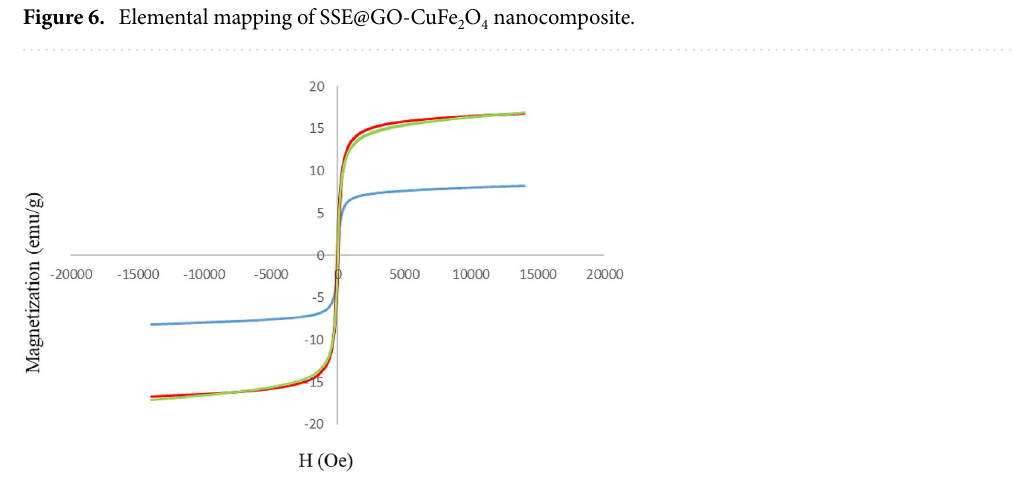
Figure 7. Magnetic hysteresis curves of CuFe 2 O 4 (red) GO-CuFe 2 O 4 (green) and SSE@GO-CuFe 2 O 4 (blue)